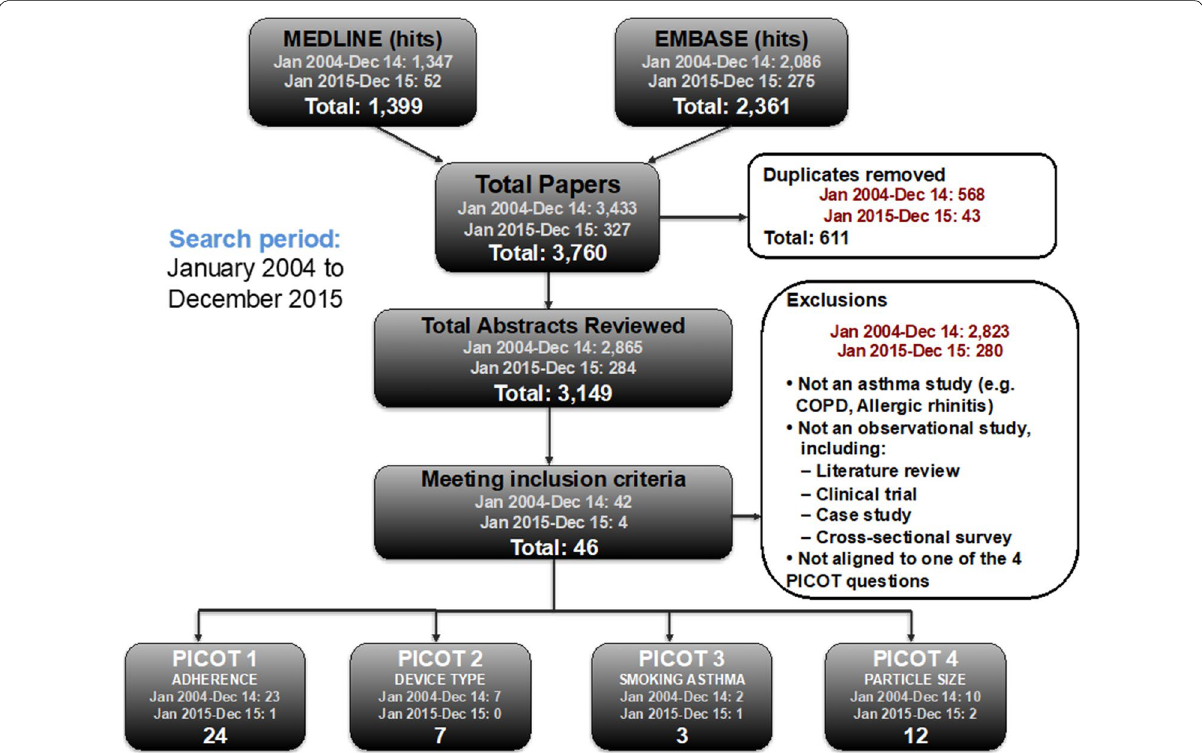
Fig. 3 Flow diagram for inclusion/exclusion of